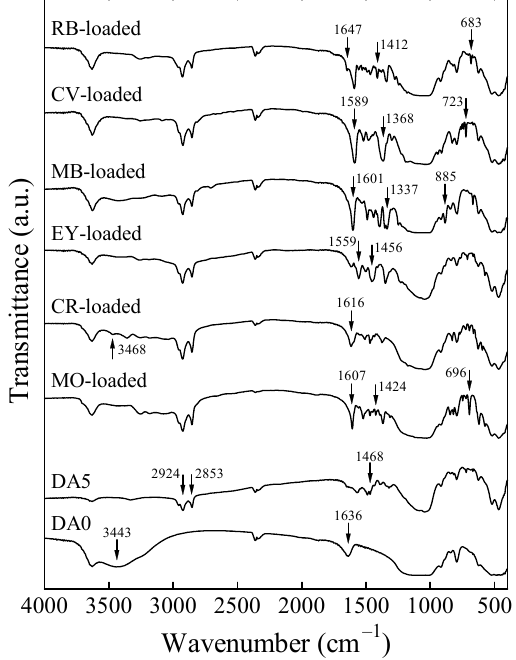
Figure 14. FT-IR spectra of DA0 (original acid clay) and DA5 samples after adsorption of MO, CR, EY, MB, CV and RB (dosage = 0.5 g/L, initial concentration = 100 mg/L, temperature = 301 K).